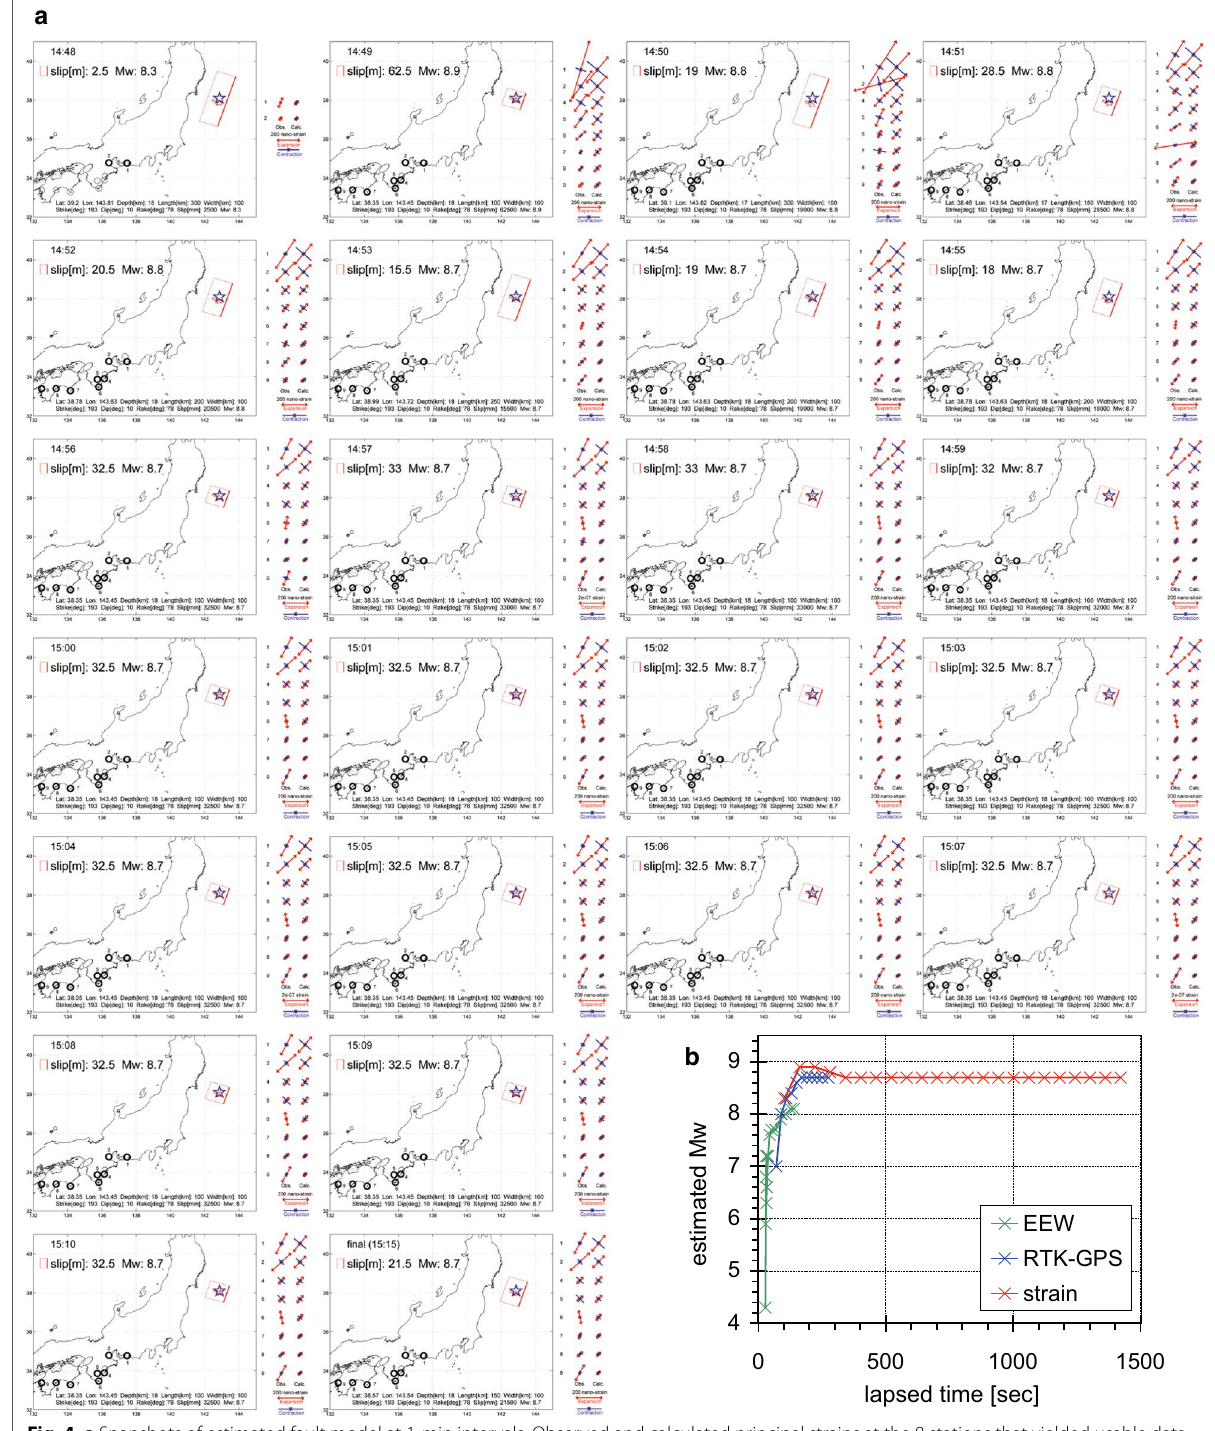
Fig. 4 a Snapshots of estimated fault model at 1-min intervals. Observed and calculated principal strains at the 8 stations that yielded usable data are shown at the right of each panel. b Time series of moment magnitude estimates based on EEW issued by JMA, RTK-GPS data (Ohta et al. 2012), and this